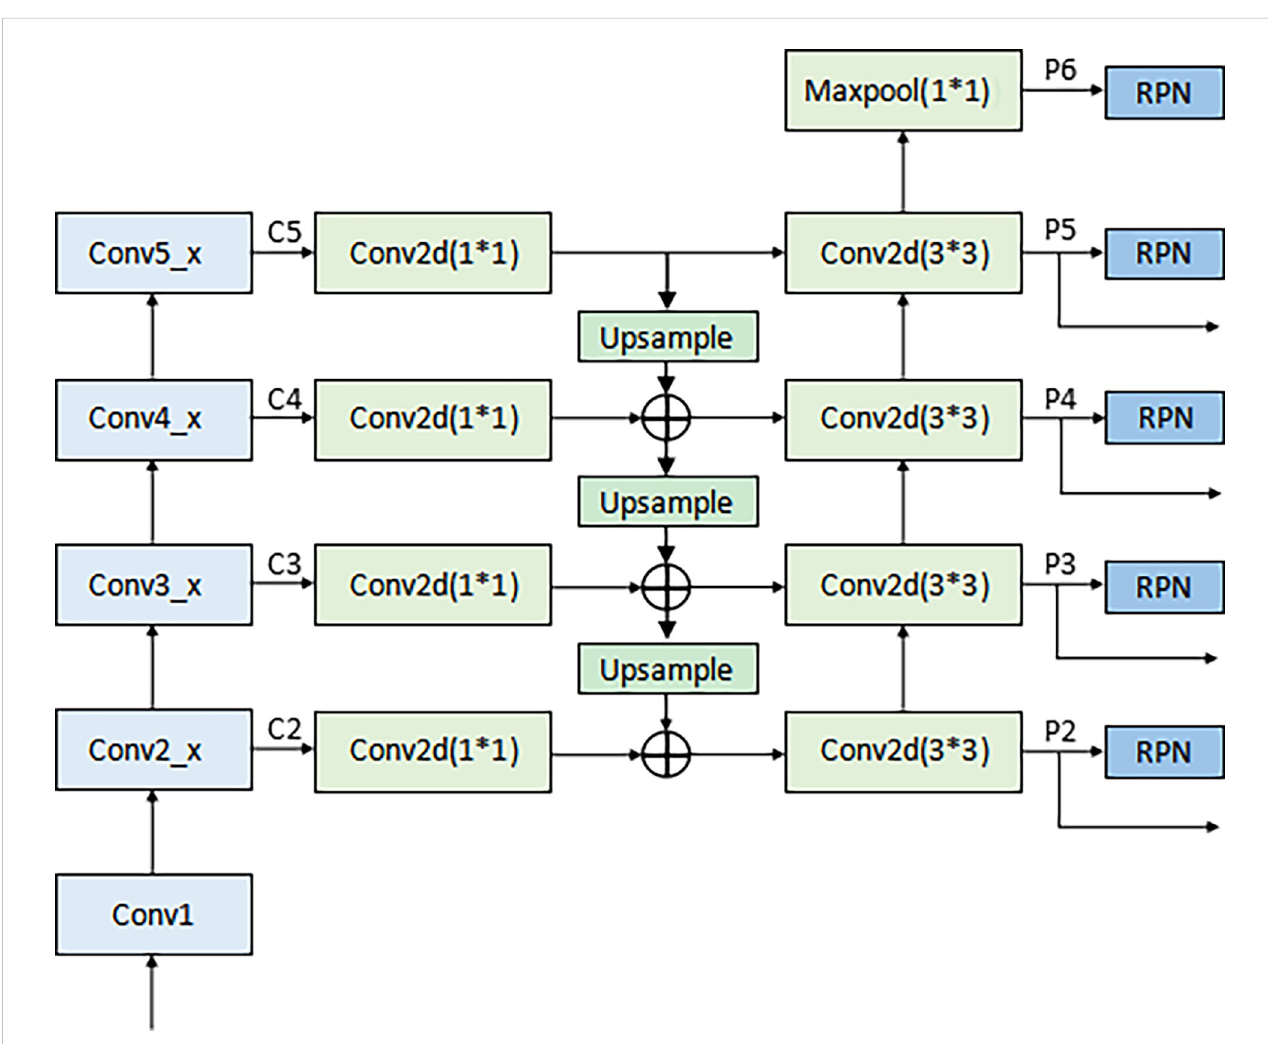
FIGURE 5 The architecture of backbone network in Faster R-CNN (ResNet50+